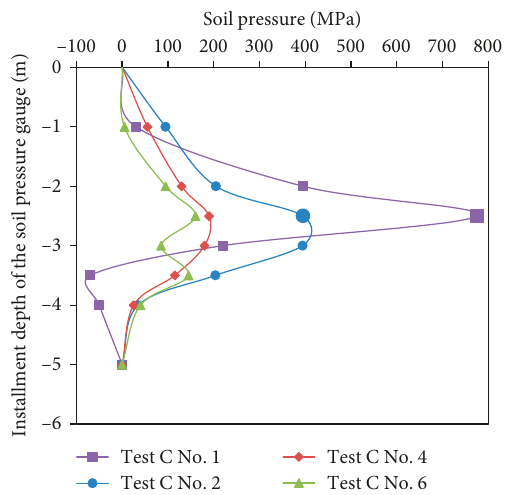
Figure 11: Variation of soil pressure with installment depth for Test